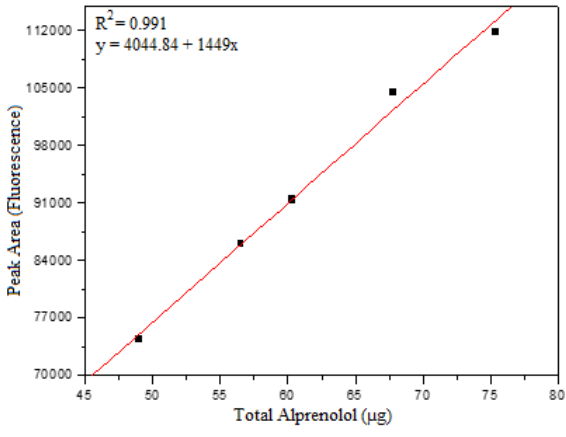
Figure 4: Fluorescence calibration plot using peak area as a function of the total (±)-Alprenolol in each calibration standard (µg).